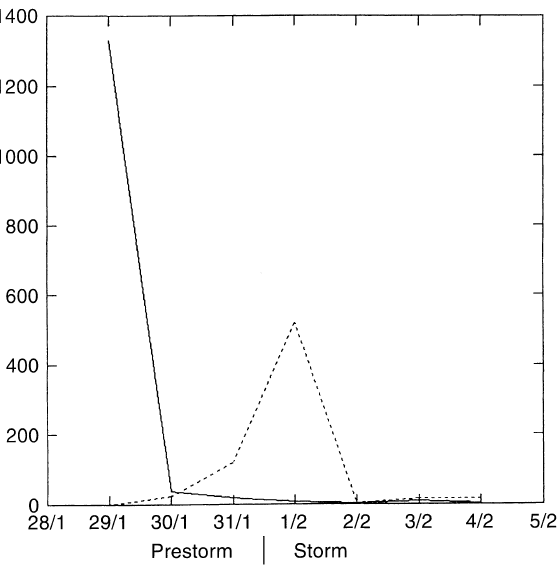
Fig. 12. Same as Fig. 4. except for 1 February 1993 at 1200 UTC